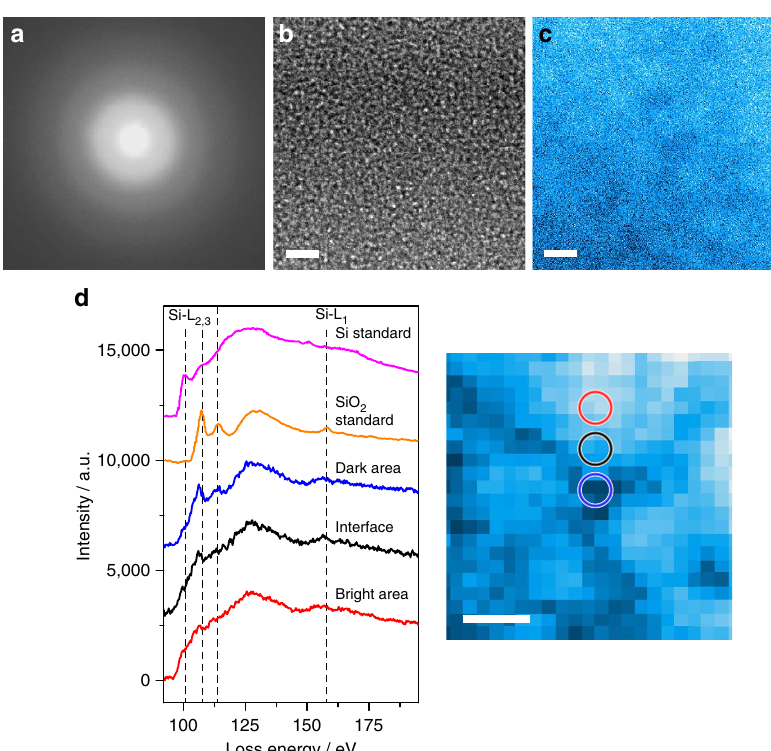
Figure 2 | TEM/STEM micrographs and EELS spectra of amorphous SiO. ( a ) Selected area electron diffraction pattern; ( b ) High-resolution TEM image; and ( c ) HAADF-STEM image of the amorphous SiO. Scale bar, 2nm. ( d ) EELS profiles (Si- K edge) taken from the dark (blue circle), bright (red circle) and interfacial (black circle) regions in the HAADF-STEM image. Standard EELS profiles of amorphous Si and SiO 2 were extracted from the literature 11 . Scale bar,